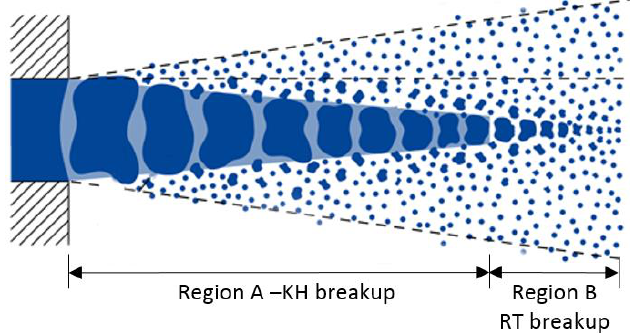
Figure 3. KHRT breakup model concept.